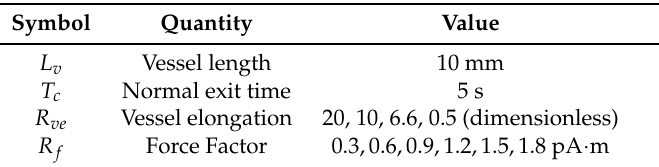
Table 2. Units for magnetic